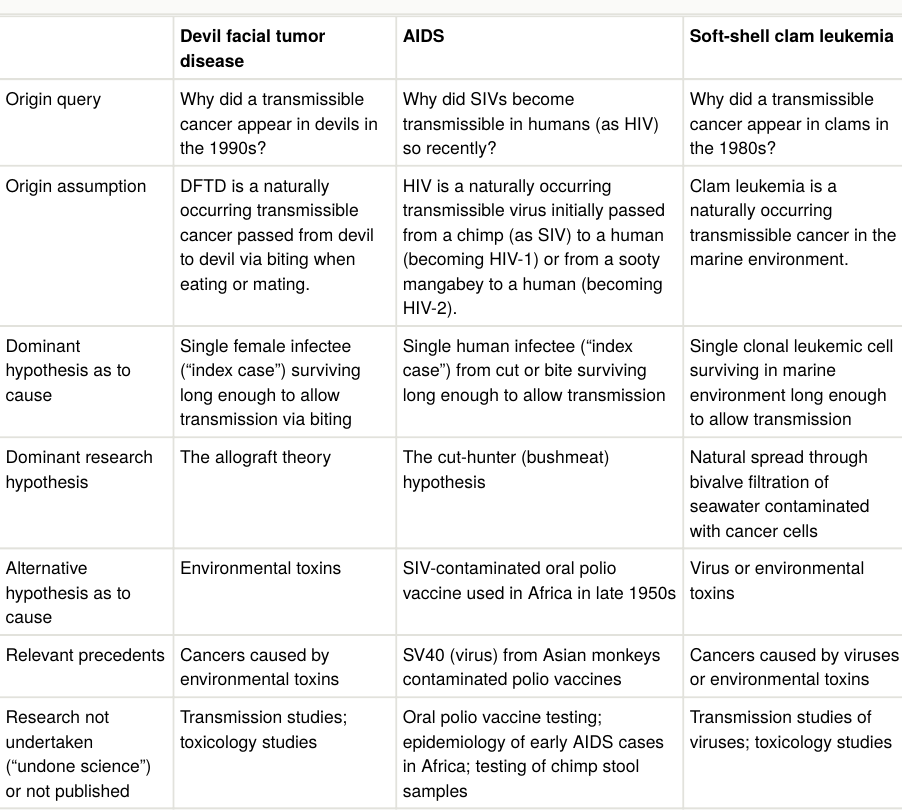
Comparisons relevant to the research programs for three new diseases: devil facial tumor disease (DFTD), AIDS and soft-shell clam